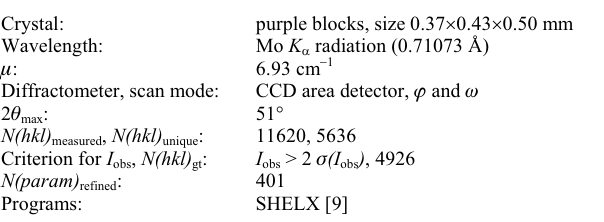
Table 1. Data collection and handling.